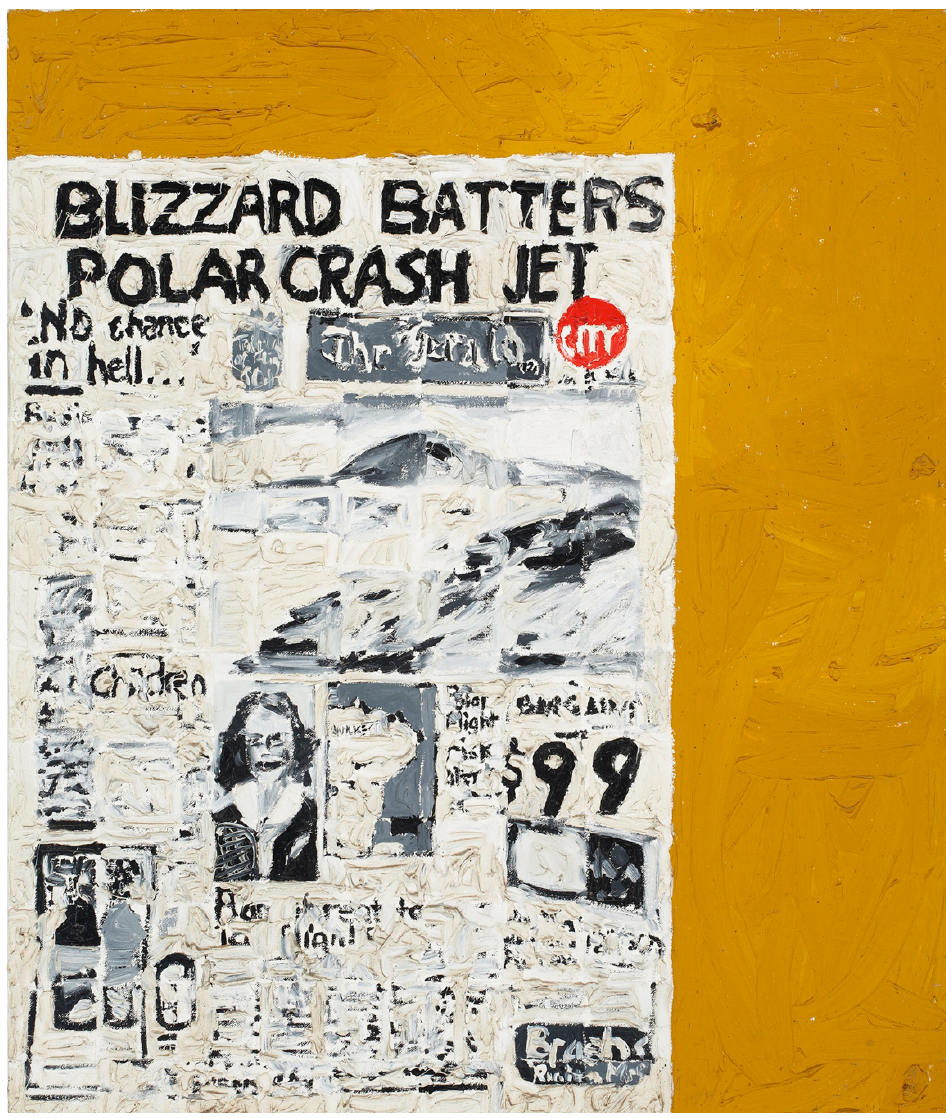
Jenny Watson, A Painted Page: The Herald 21/11/79 , 1979, oil on cotton duck, 60 x 76 cm. Collection of the artist, courtesy of Anna Schwartz Gallery. Copyright Jenny